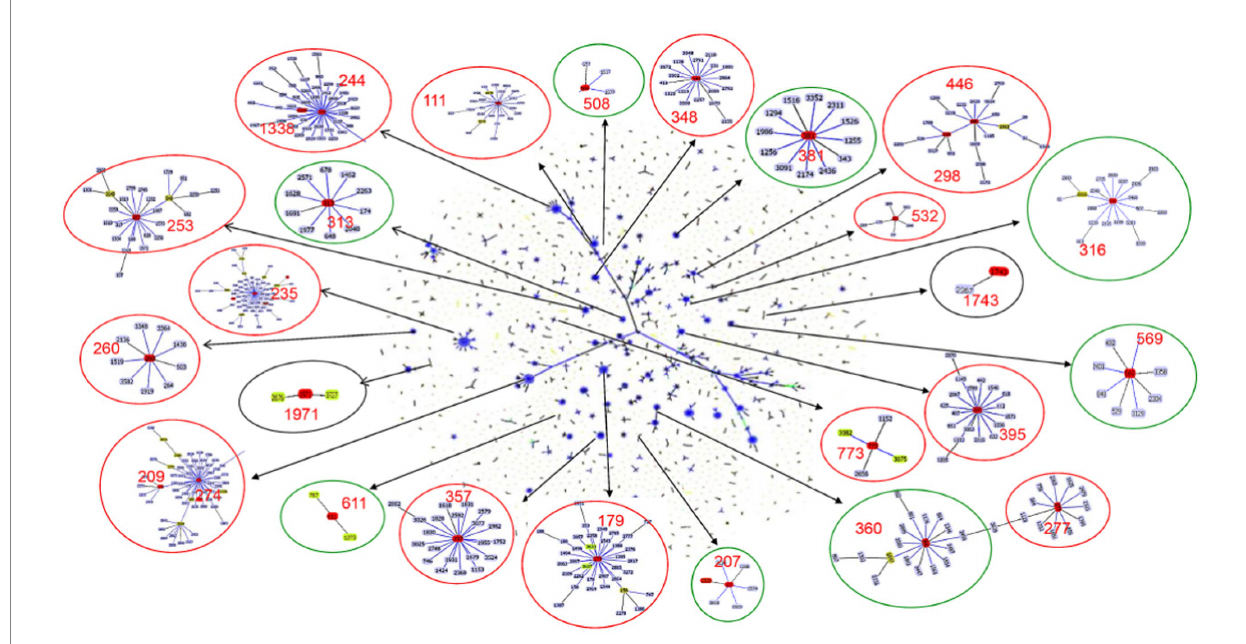
FIGURE 2 Population snapshot of P. aeruginosa . The 3,729 sequence types listed on the P. aeruginosa PubMLST database (http://pubmlst.org/paeruginosa, 2022/07/11) are displayed in a single eBURST diagram by setting the group definition to zero of seven shared alleles. Each dot represents a ST, and lines connect single-locus variants. The identified clones in this study were marked in red in each group of related STs. A red circle surrounded the groups reported as international high-risk clones, the groups with the new potential high-risk clones were surrounded by a green circle, and a black circle surrounded the local risk clones identified in this